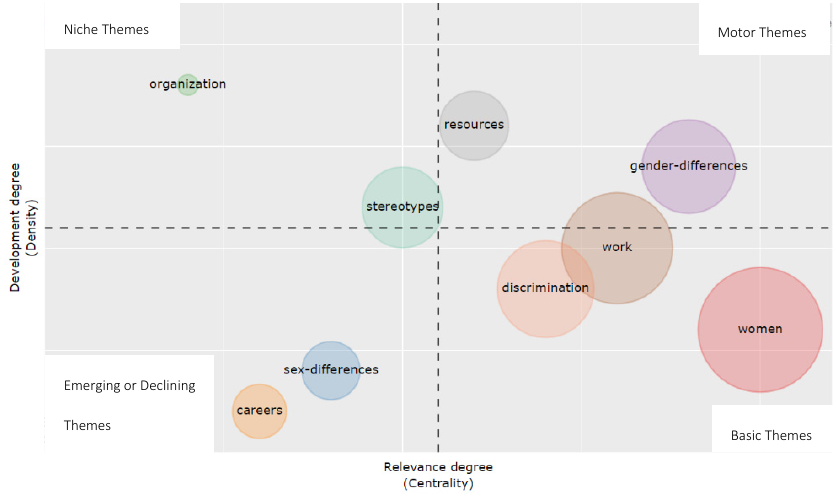
Figure 8. Thematic Figure 8. Thematic map.